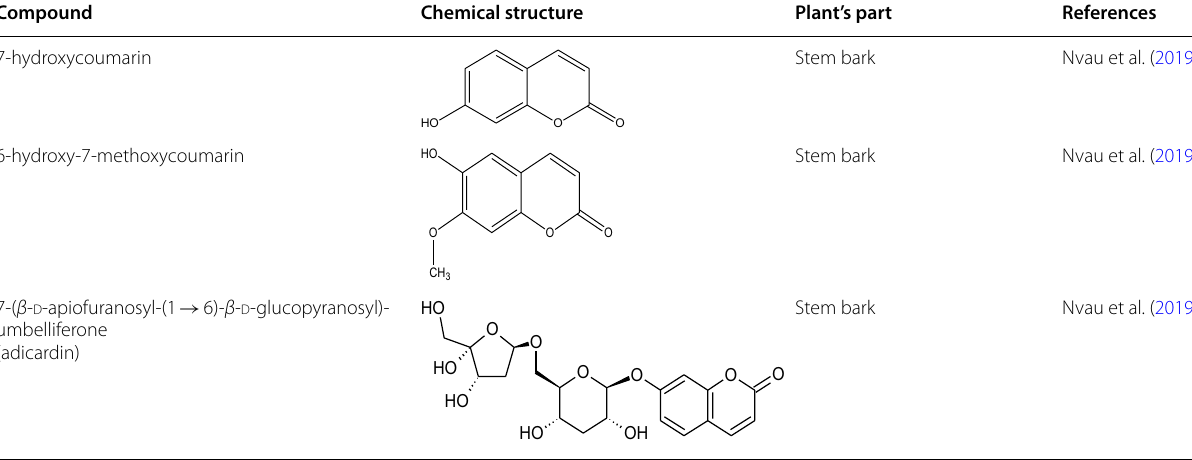
Table 2 Coumarins isolated from Breonadia salicina